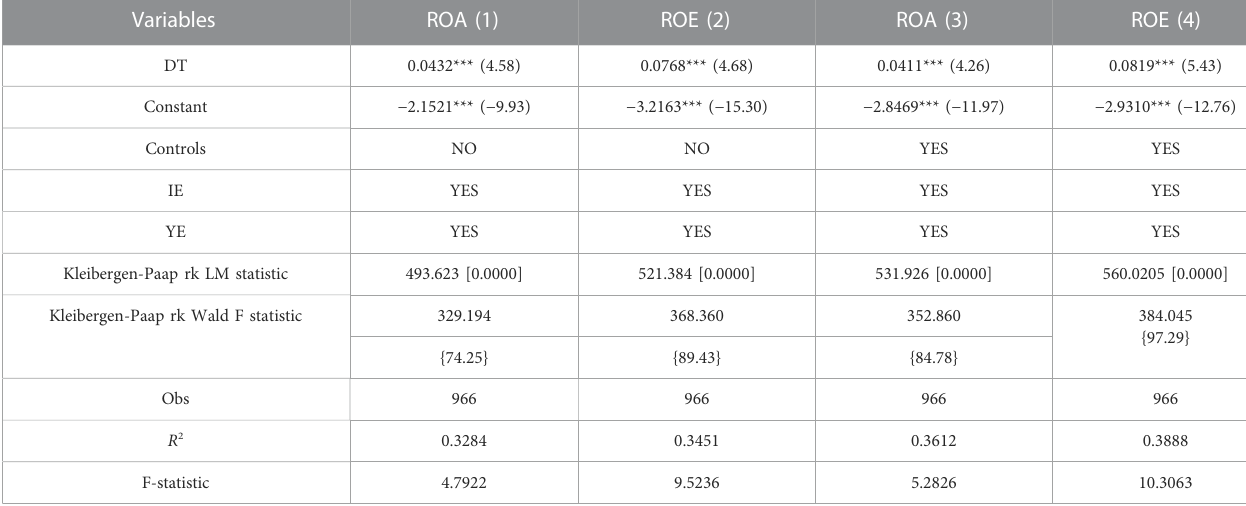
TABLE 6 Robust check: Instrumental variable estimation.